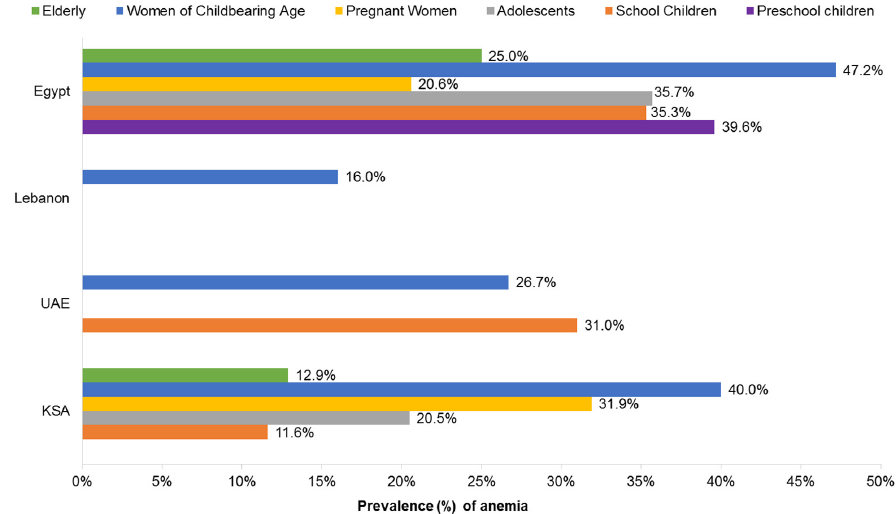
Figure 2. Prevalence of anemia in the Middle East by age and gender. (Sources: KSA [60,67,83,86,88]; UAE [63,82]; Lebanon [85]; Egypt [61,72,89]).